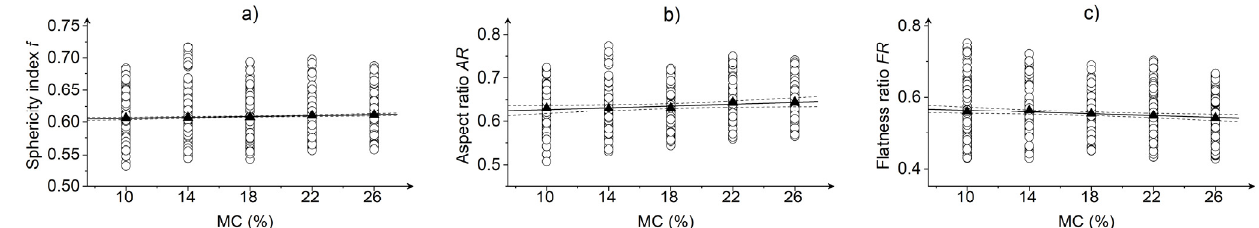
Figure 6. The relationship between moisture content and selected shape characteristics for maize: ( a ) sphericity, f = 0.000353 MC + 0.602, R 2 = 0.922, ( b ) aspect ratio, AR = 0.00105 MC + 0.617, R 2 = 0.781, ( c ) flatness ratio, FR = − 0.00132 MC + 0.577, R 2 = 0.873; ○ —data, ▲ —mean, ─ —fitted curve, - ---—95% confidence band.